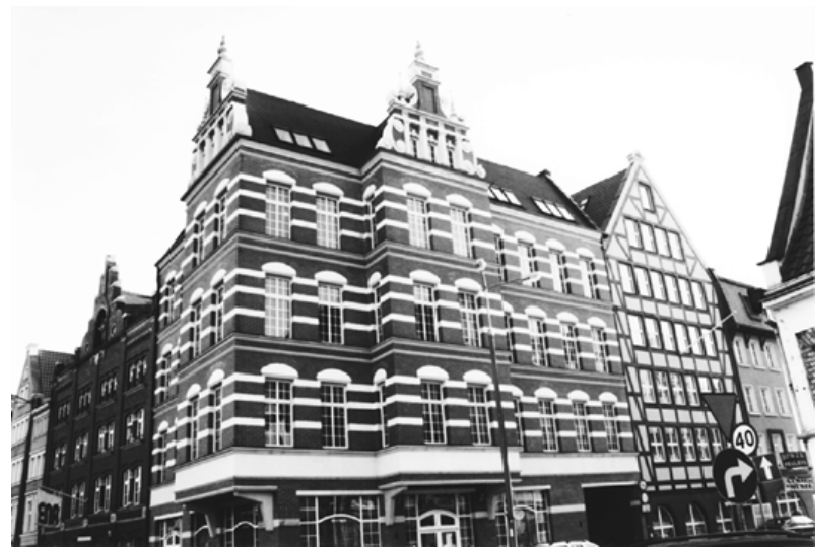
Figure 9. Tenement houses on St ą giewna Street in Gda ń sk. Source: A. Taraszkiewicz.